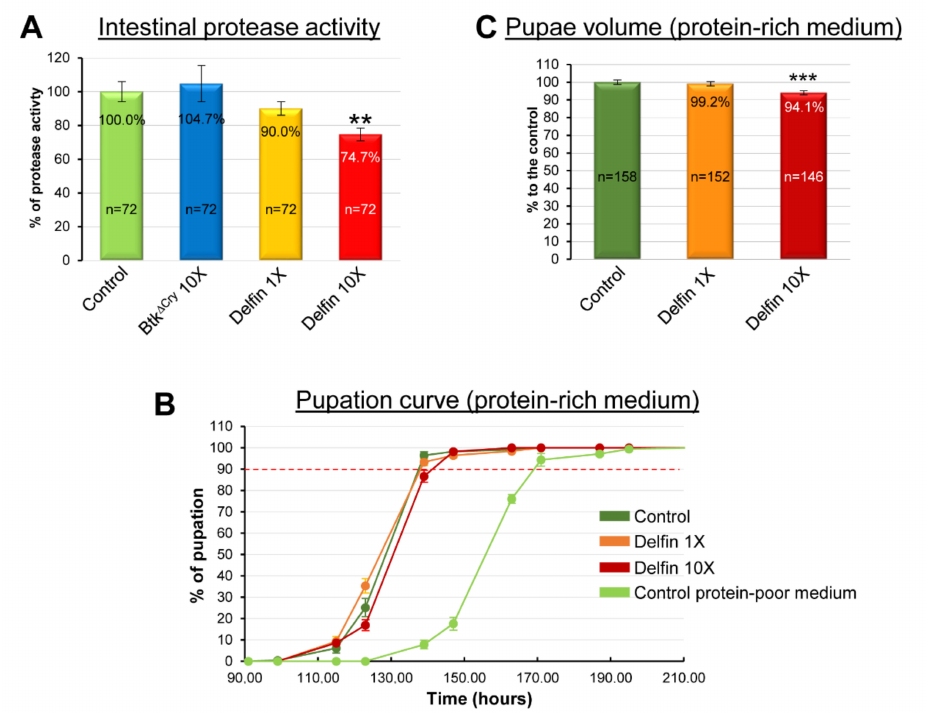
Figure 3. Influence of a protein-rich-diet on Delfin impacts ( A ) Measurement of the protease activity of the intestine of L3 raised on control medium contaminated with H 2 O (control) or with 10X concentrations of spores of Btk ∆ Cry or Delfin or 1X concentration of spores of Delfin. ( B ) Pupation curve of larvae raised on a protein-rich medium (10% yeast instead of 2%) contaminated with 1X or 10X concentrations of Delfin. Note the shortening of the developmental time of the control larvae raised on the protein-rich medium (10% yeast) compared to larvae raised on the protein-poor-medium (2% yeast). ( C ) Pupae volume derived from larvae raised on the protein-rich medium and in the di ff erent conditions listed on the x-axis. Errors bars represent the SEM. ** p < 0.01, *** p < 0.001 compared with